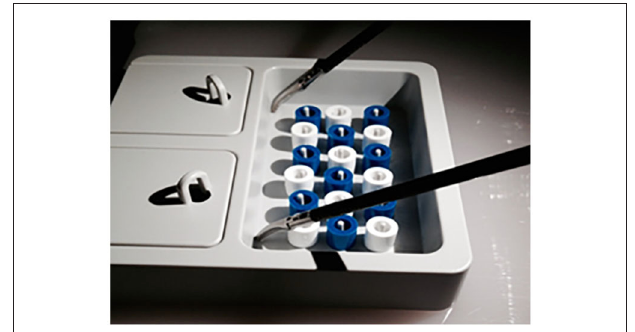
FIGURE 1 | A practice module “Pack your luggage” of the Luebeck Toolbox: Open-box and sorting sleeves according to color.